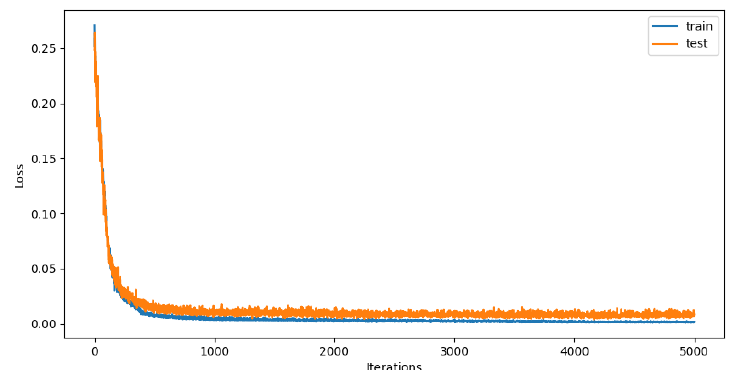
Figure 7. Training and testing iteration loss information.